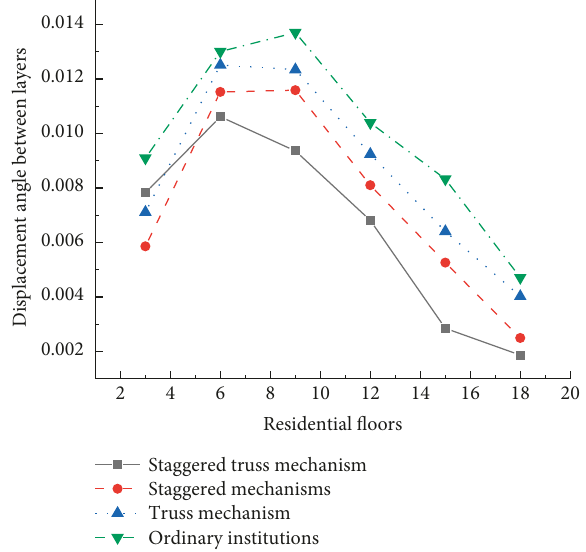
Figure 4: Interstory displacement angles of different floors under small earthquakes.